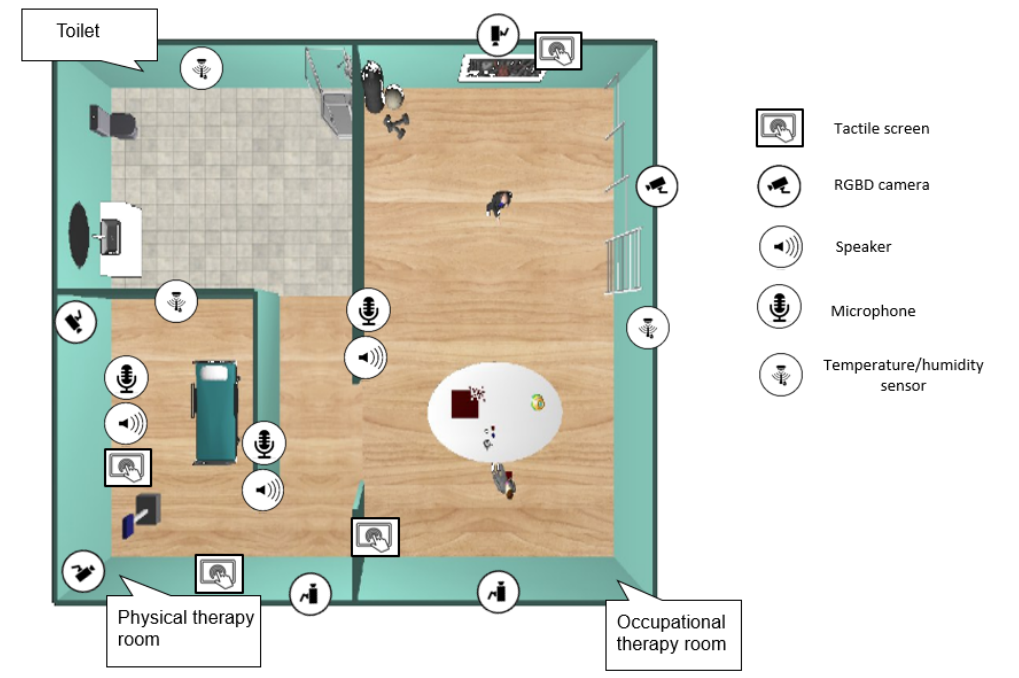
Figure 9. Partial view of the proposed CPS-AAL for caregiving